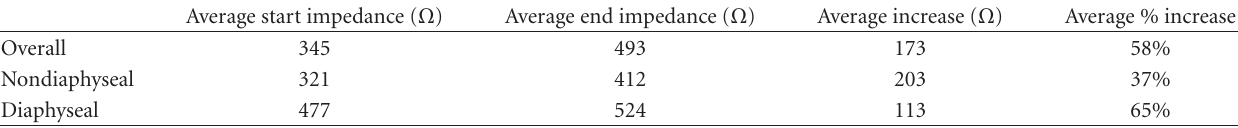
Table 1: Impedance change during PRFTC procedures according to anatomical